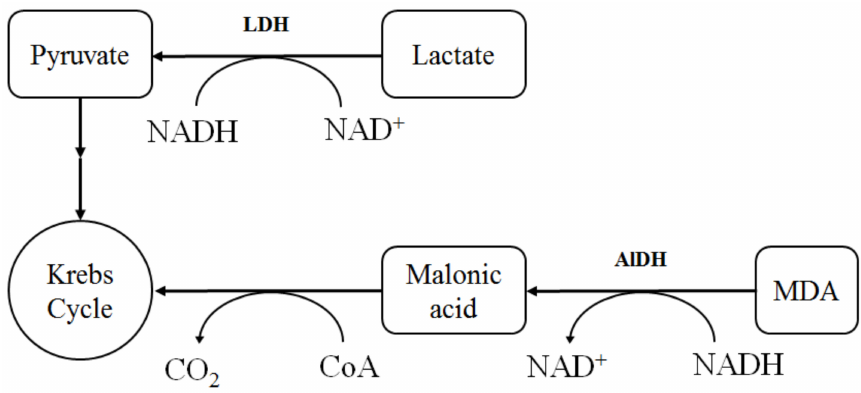
Figure 10. Participation of the NAD + /NADH pair in the reactions of some